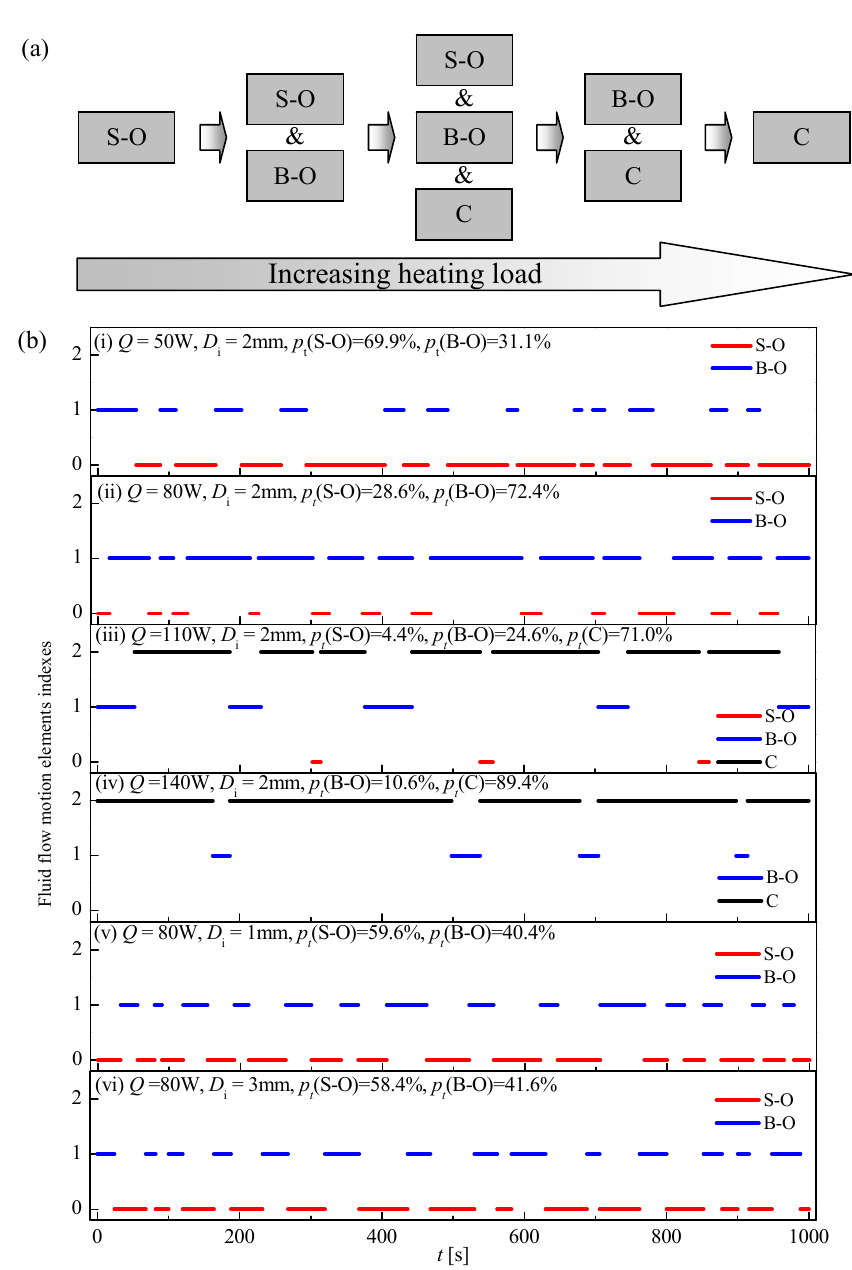
Figure 4. Variation of fluid flow motions with increasing heating load: ( a ) schematic of change in fluid flow motions with increasing heating load; and ( b ) time series of fluid flow motions and their corresponding duration fractions under different heating loads and inner diameters. Fluid flow motions mode index: 0: S ‐ O; 1: B ‐ O; and 2: C.